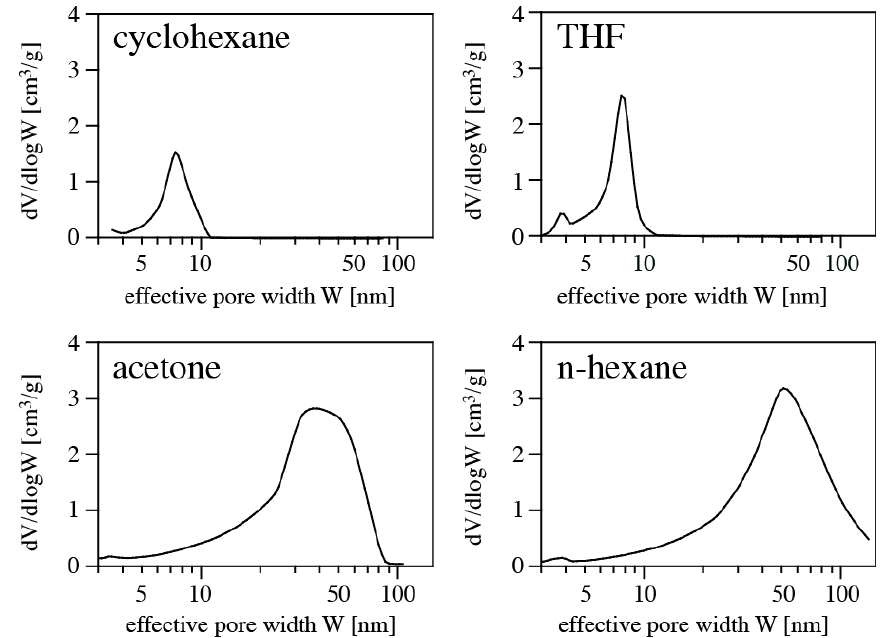
Figure 4. Pore size distributions of PMHS/DVB polymer aerogels synthesized in cyclohexane ( top left ), tetrahydrofuran ( top right ), acetone ( bottom left ), and n-hexane ( bottom right ).